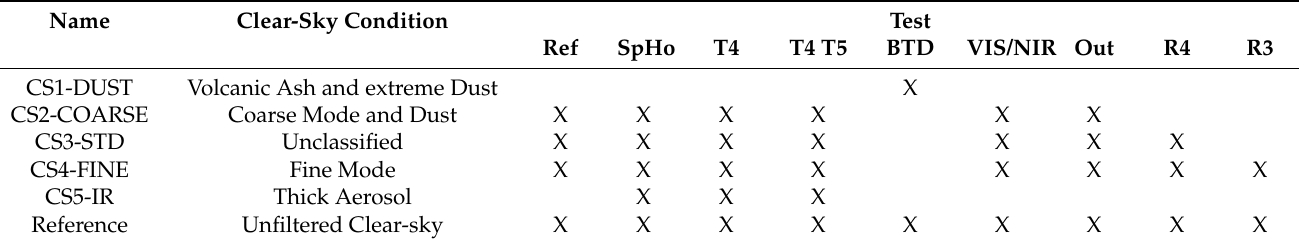
Table 4. Different types of clear-sky conditions and the associated radiometric tests applied accord- ingly. The unfiltered clear-sky condition corresponds to the case for which the removal of cloudy pixels is applied without any specific filtering, i.e., applying all tests and types of removal.